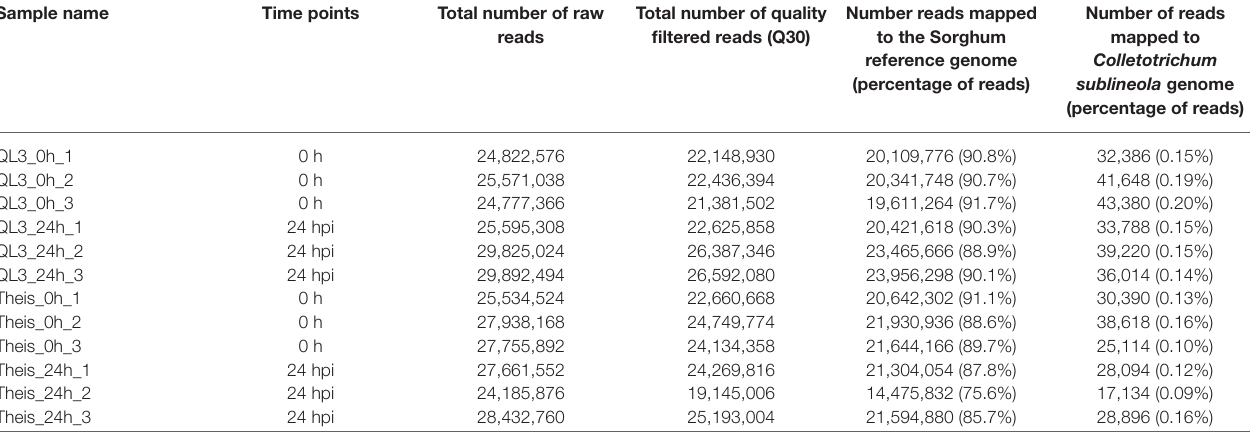
TABLE 2 | Statistics of differentially expressed genes in resistant and susceptible cultivars. Sample condition Total number of